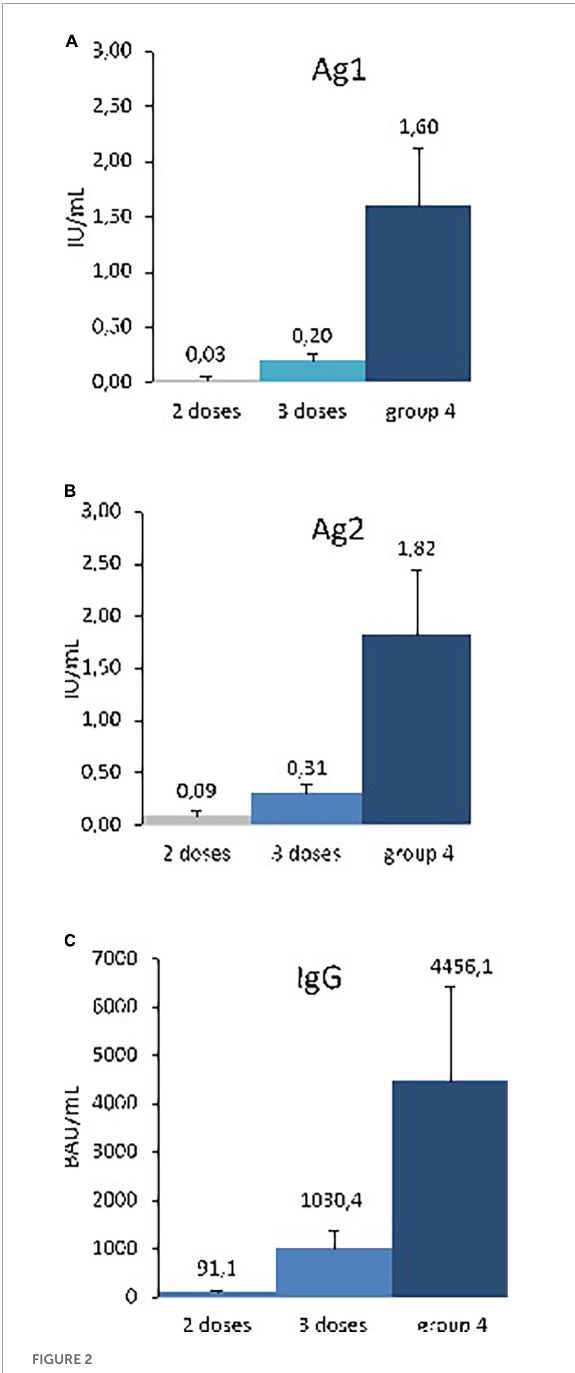
FIGURE2 Specific T-cell and humoral responses after 2–4 doses, 3–5 months after vaccination. Specific T-cell response as stimulated IFN- γ release: (A) QuantiFERON response to antigen 1, (B) QuantiFERON response to antigen 2, given in IU/mL. Serological response (C) Anti-SARS-CoV-2 IgG response, given in binding antibody units per mL (BAU/mL), at months 3–5, after 2–4 doses of vaccination. The three dosages were done in the same Heart transplant patients (group 2 doses, n = 8; group 3 doses, n = 38, group 4, n = 5. Mean ± SEM are indicated. p < 0.01 for Ag1, Ag2, and IgG 2, comparaison between doses by Kruskal-Wallis